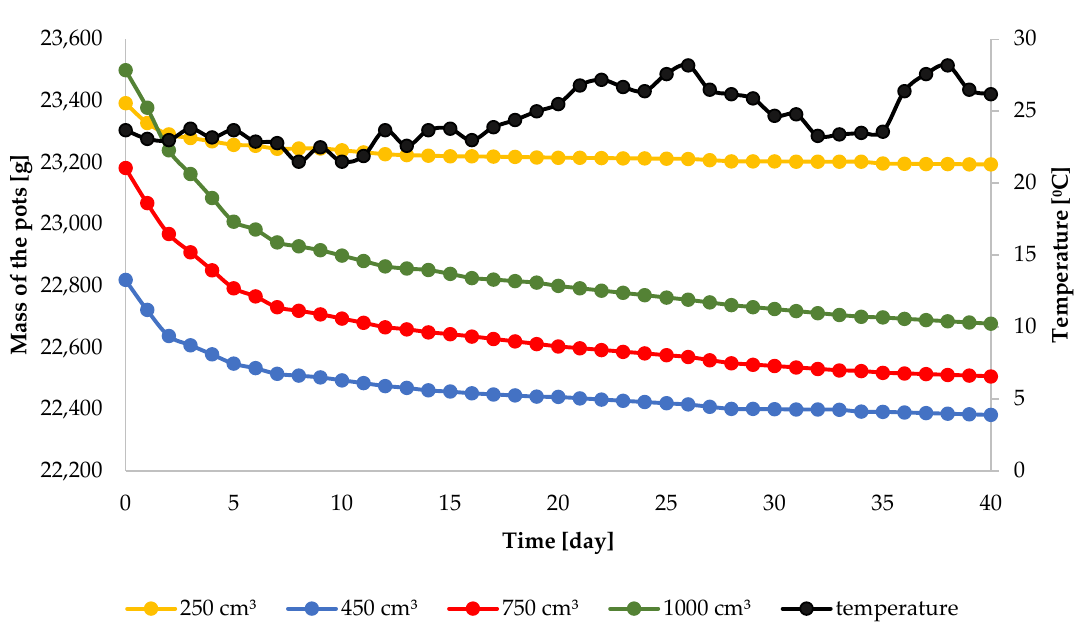
Figure 4. Dynamics of pot mass during 40 days after the injection of 250, 450, 750 and 1000 cm 3 of water at the depth of 5 cm.